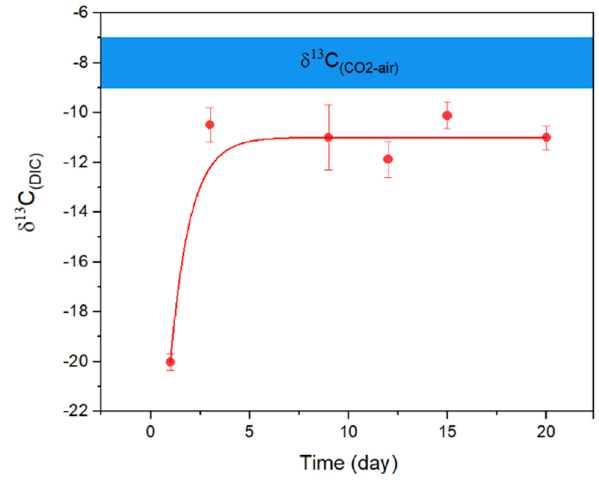
Figure 3. Evolution of δ 13 C (DIC) in marine microbial culture over 20 days of incubation showing that the isotope composition approached the level of current atmospheric CO 2 (blue bar at approximately − 8‰). Error bars represent the range of the measurements (n = 3).